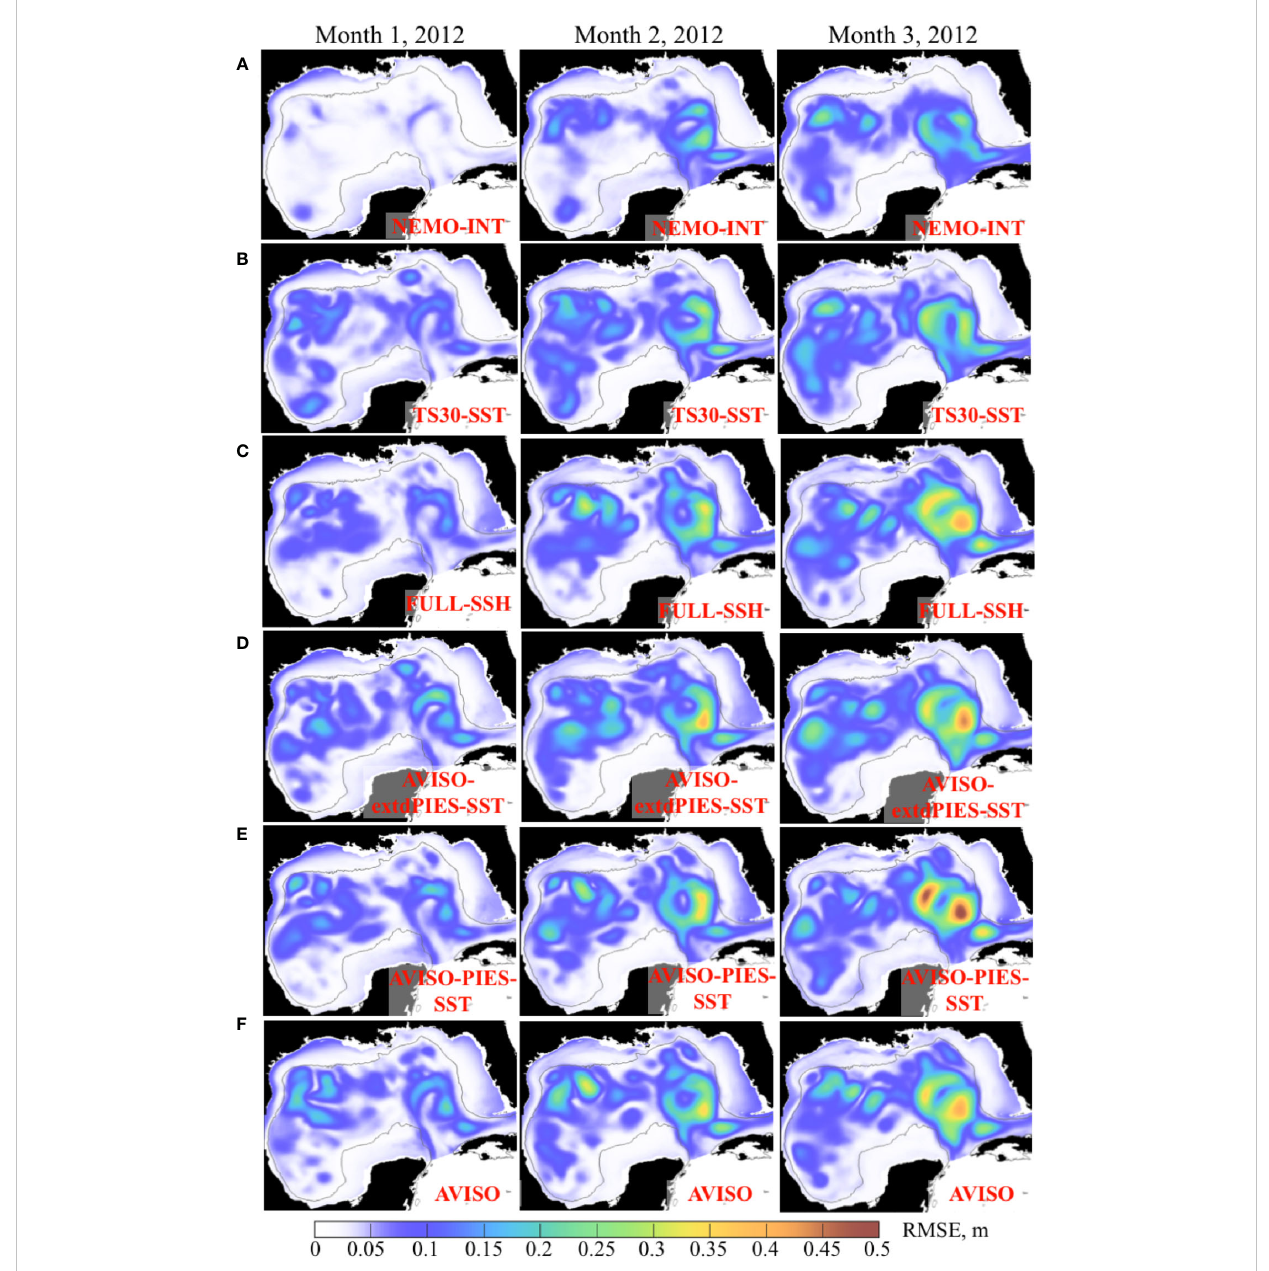
FIGURE 12 Monthly mean RMSE between SSH (m) from the 3-month OSSE forecasts started in January – February 2012 and the NEMO NR. The RMSE for months 1 through 3 are in the columns. The OSSE forecast groups are shown in the rows (A – F) with the forecast names shown in the